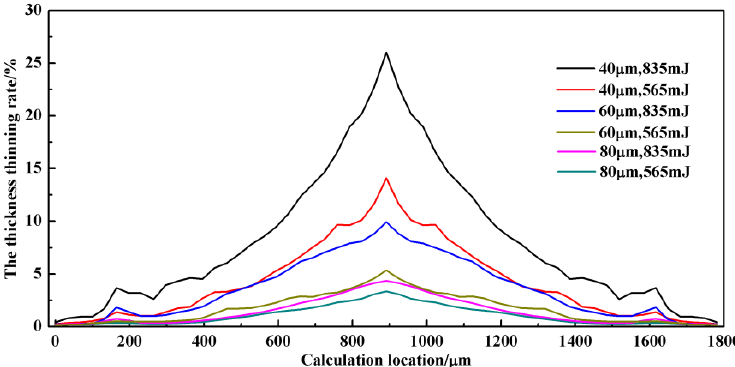
Figure 11. The thickness thinning rate distribution of the micro bulging parts in the simulation.